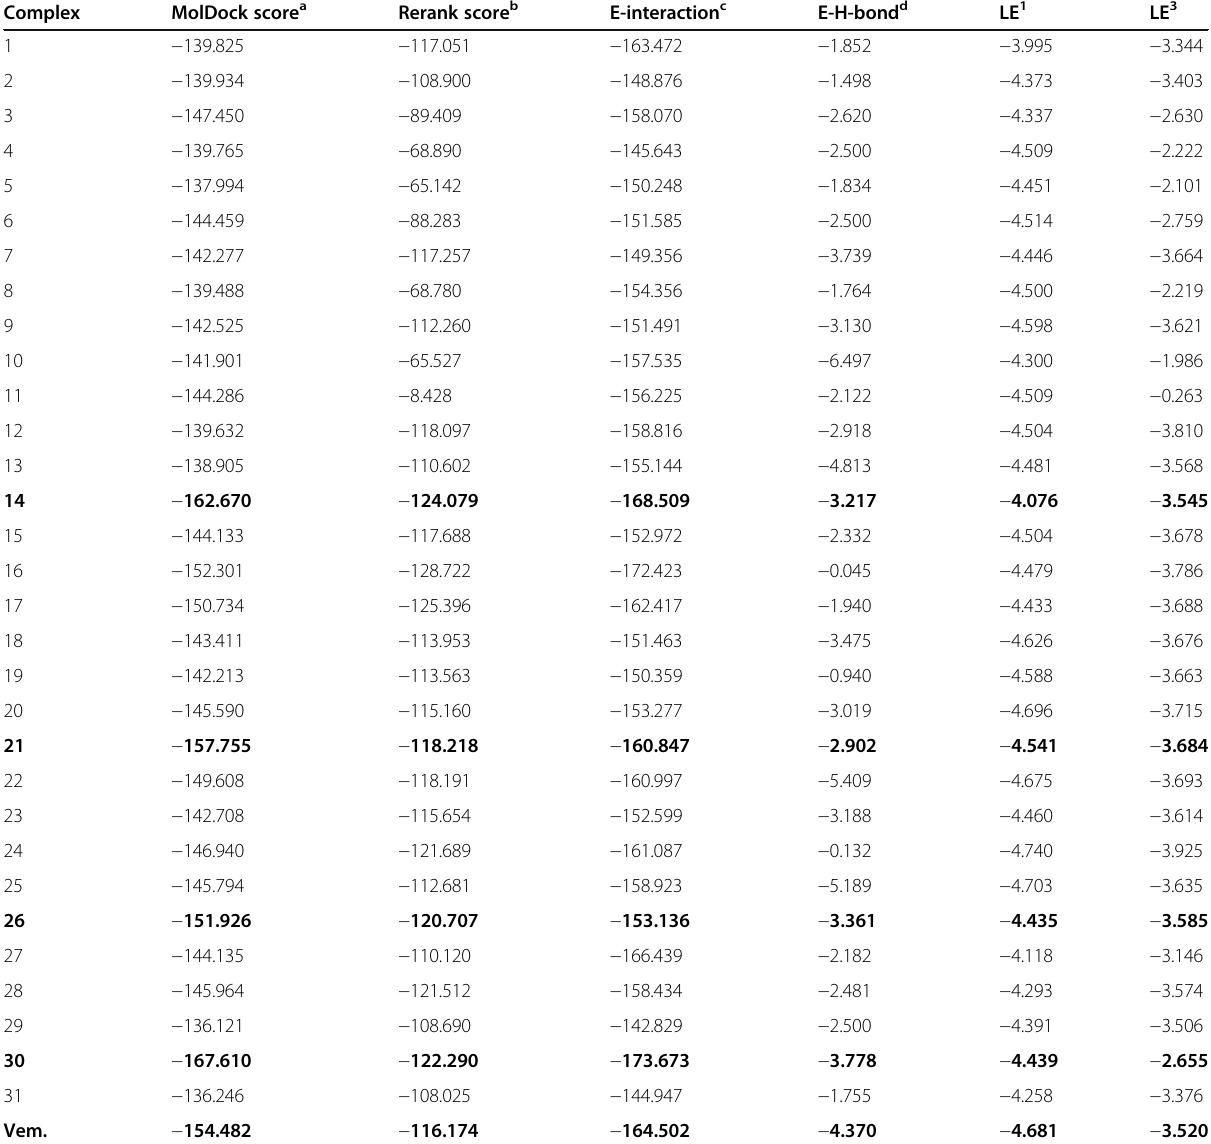
Table 2 The docking results (scores) of the studied compounds with vemurafenib as reference Complex MolDock score